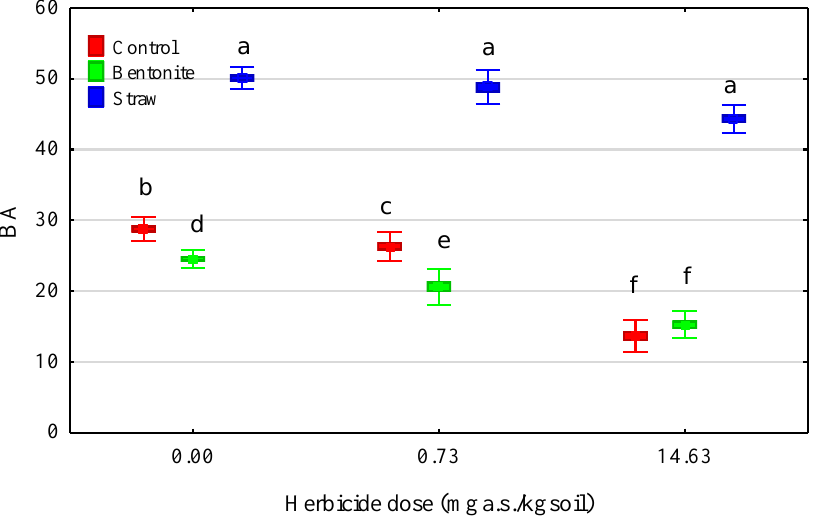
Figure 7. Effect of Successor T 550 SE on soil quality index (BA). The same letters denote homoge- neous groups.